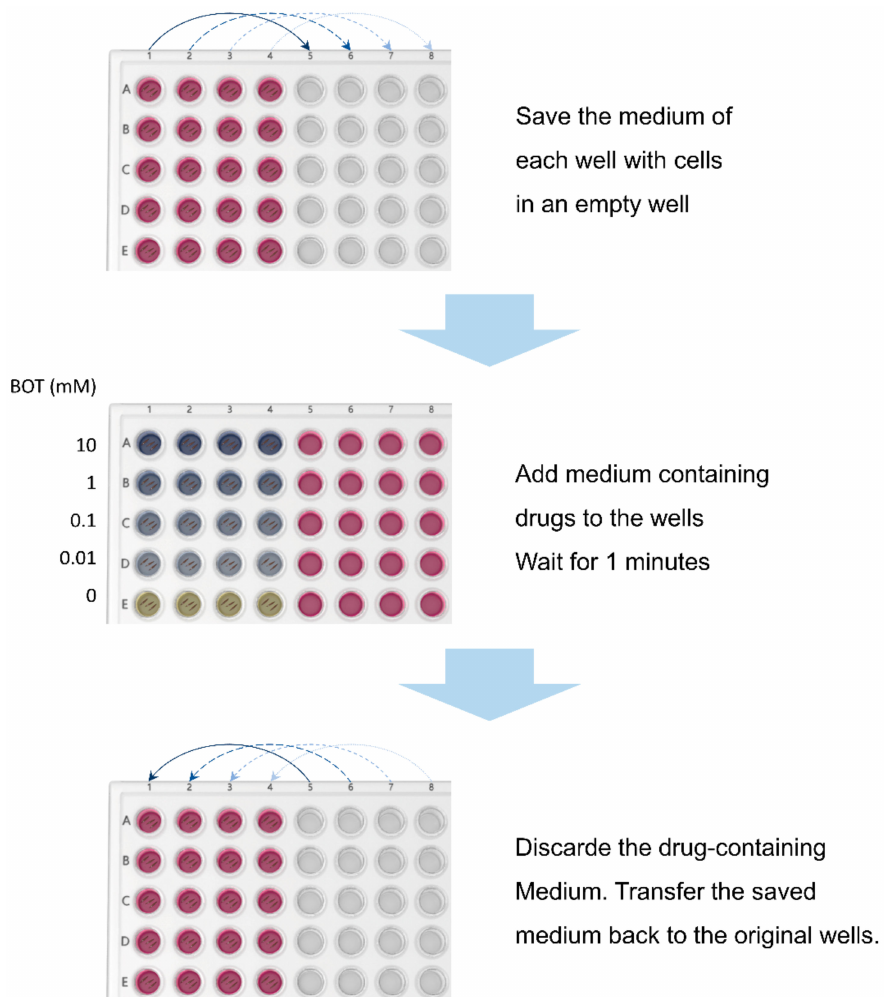
Figure 1. An illustration of the procedure of the in vitro model for mouth washing. Cells were seeded into wells of a 96-plate plate. For each washing, the medium of each well containing cells was saved in an empty well; medium containing various drugs of various concentrations was added to the corresponding wells. After 1 min, the drug-containing medium was discarded and the saved medium was transferred back to the original wells. The treatment was carried out twice